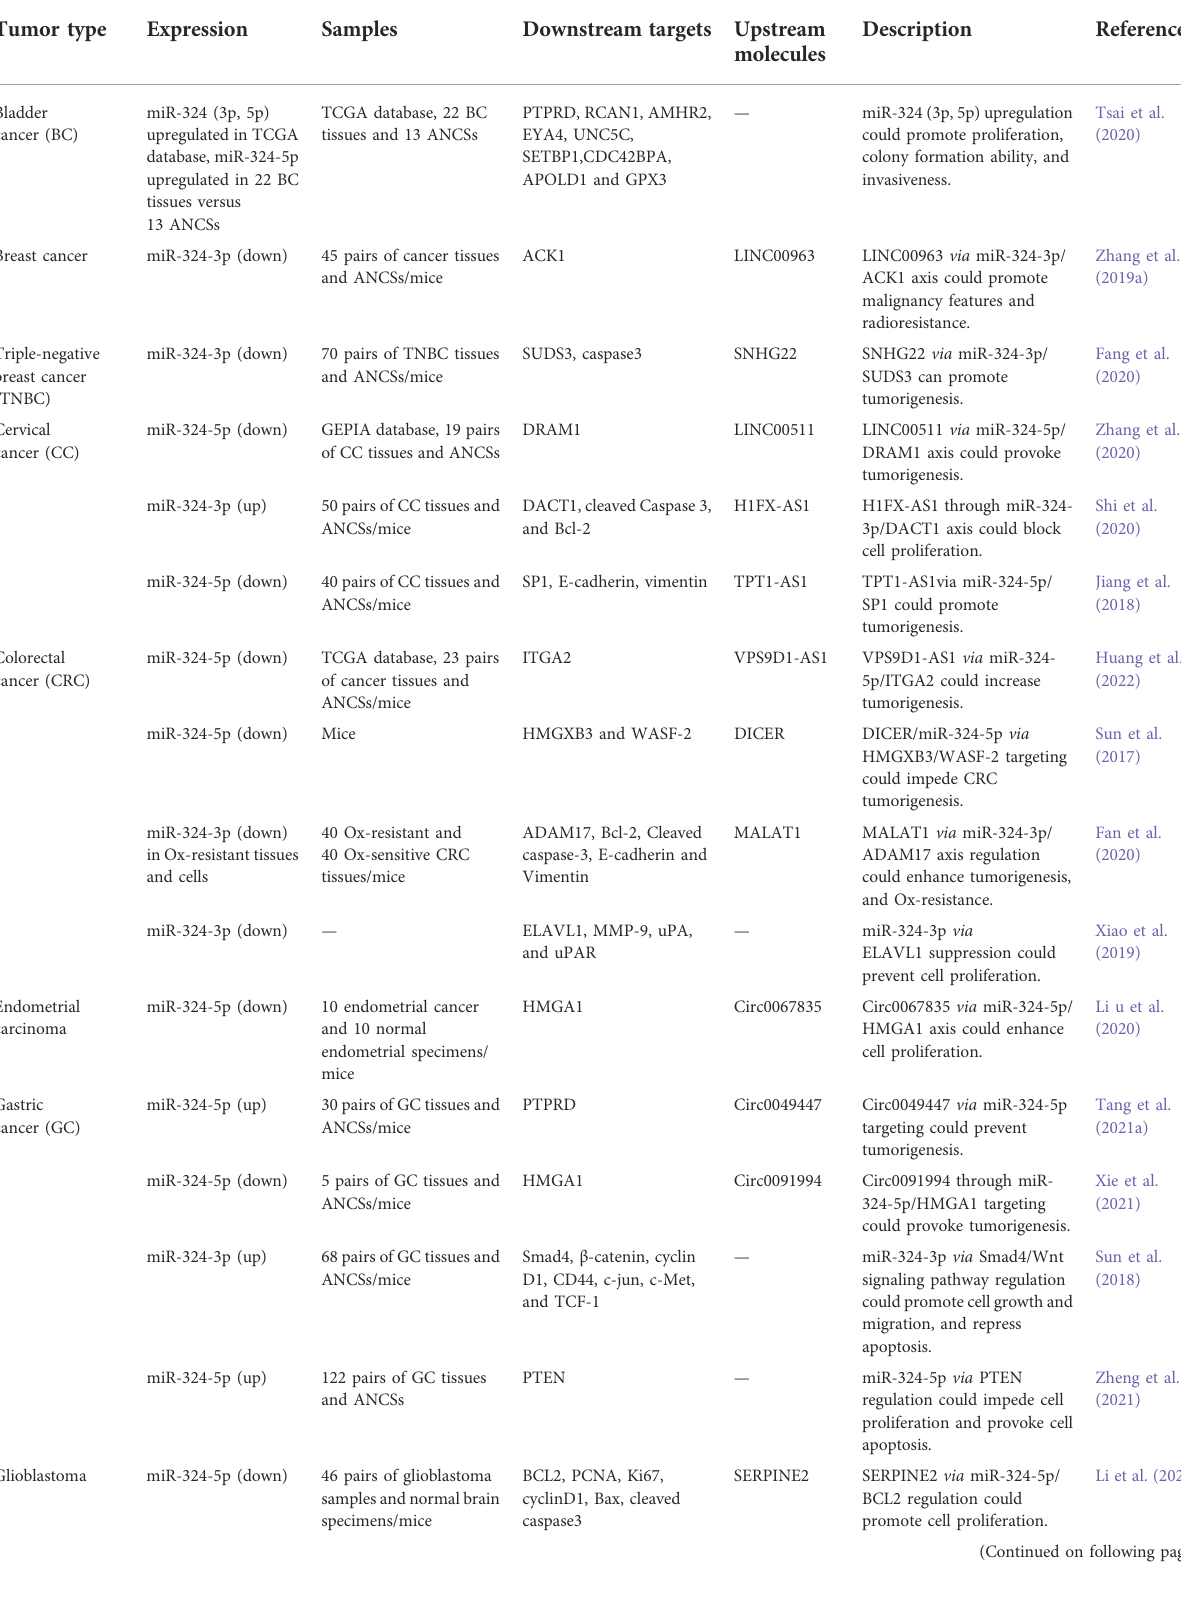
TABLE 1 miR-324 in cancers (ANCS, adjacent non-cancerous sample; OX, oxaliplatin; TMZ, temozolomide; MDR, multidrug resistance; FNA, fi ne needle aspiration; LNM, lymph node